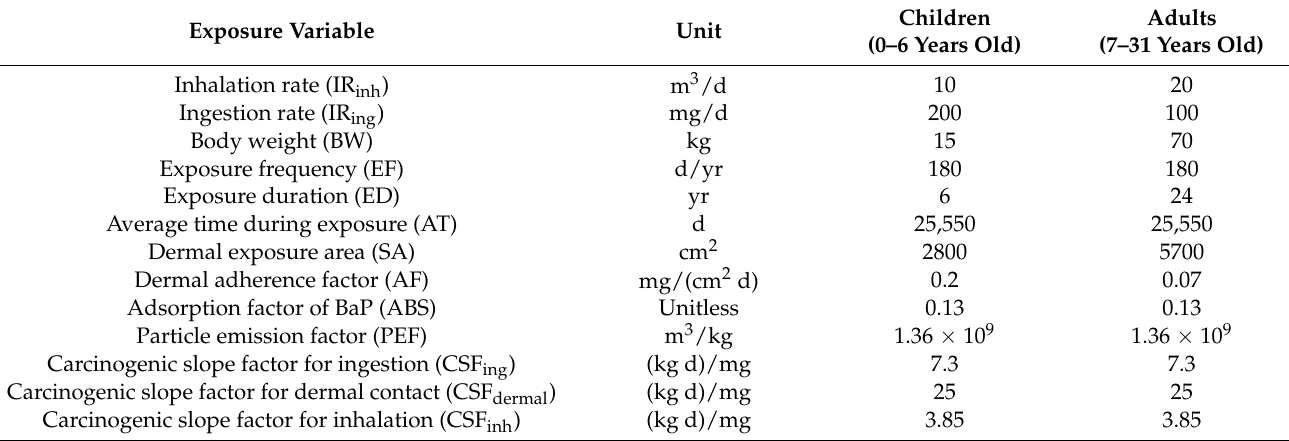
Table 2. The values of ILCR parameters to children and adults in street dust, modified from